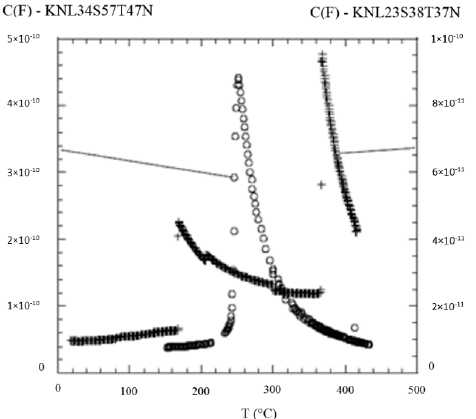
Figure 12. Variation of dielectric properties with temperature for KNL23S38T37N and KNL34S57T47N. (Reproduced from [6]. Copyright © 2012 Elsevier Masson SAS. All rights